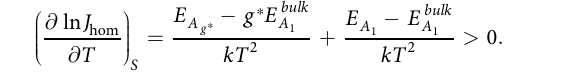
interpolated from the measured values of S ln mined by the three measurement points: